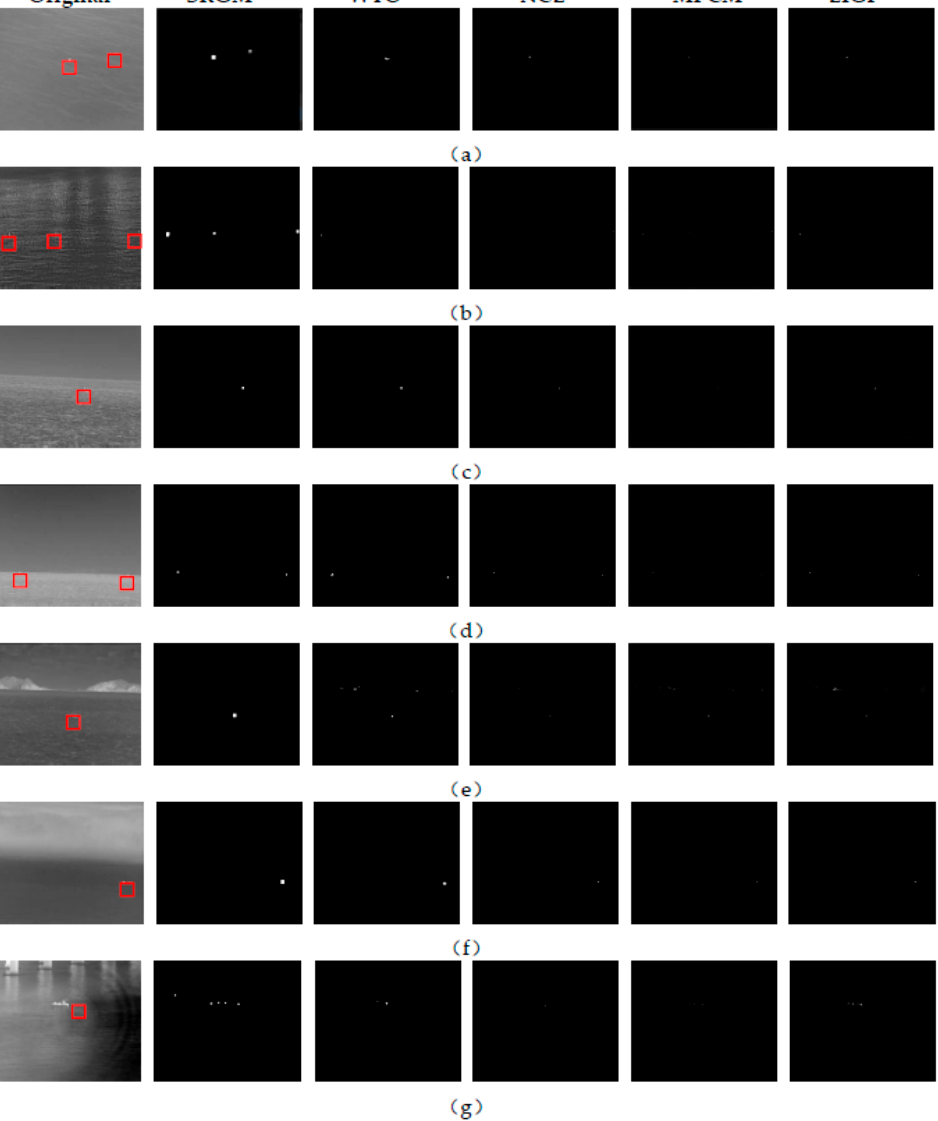
Figure 13. Detection results of the above five algorithms: ( a ) two targets with different contrast on a calm sea; ( b ) three targets with different contrast on the sea with uneven brightness; ( c ) target on the sea with obvious waves; ( d ) two targets on the horizon line; ( e ) island interference in the image; ( f ) fog interference in the image;( g ) extremely small and dim target